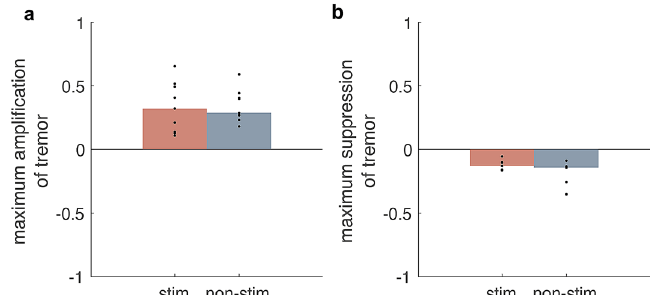
Figure 2. Group analysis of tremor modulation with peripheral stimulation. Maximum amplification ( a ) and suppression ( b ) of tremor amplitude across patients during phase-specific stimulation (red bars) and no-stimulation (grey bars) have been statistically compared using a Wilcoxon signed rank test (tremor amplification p = 0.702 and tremor suppression p = 0.129). Black dots indicate individual maximum changes in tremor severity and bars their